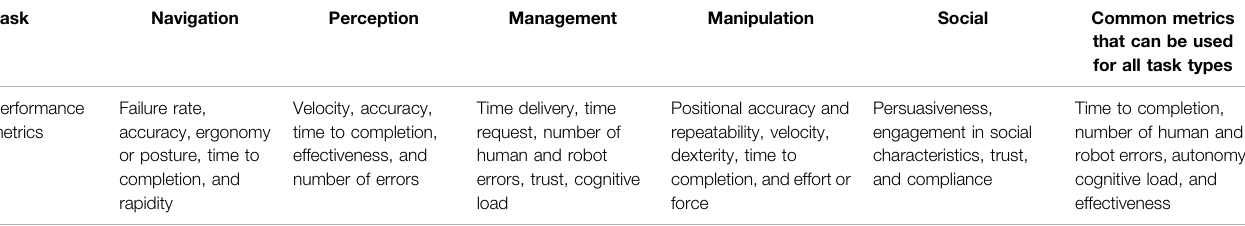
TABLE 1 | Some metrics considered for the evaluation of HRC classi fi ed based on the task types (Steinfeld et al., 2006; Bütepage and Kragic, 2017; Nelles et al., 2018).